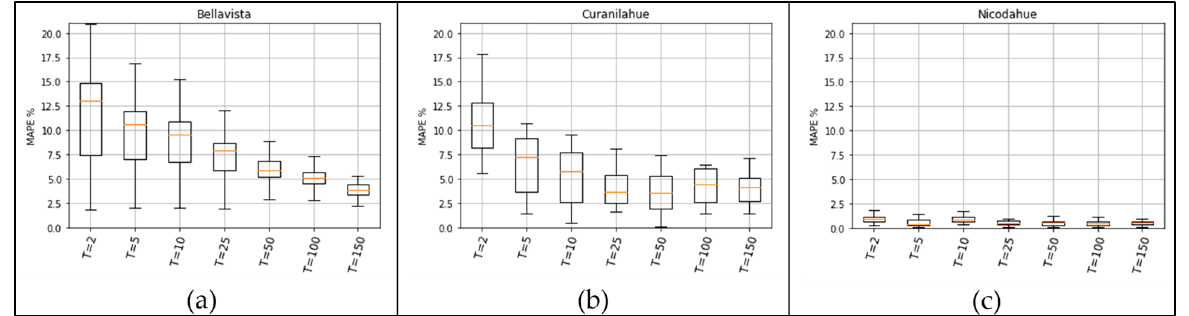
Figure 4. WSE-RS vs. WSE-T results for each cross section of the ( a ) Bellavista, ( c ) Curanilahue, and ( e ) Nicodahue rivers for different return periods. The dashed blue line shows the 1:1 ratio of WSE- T to WSR-RS and the red line shows the trend of the results and correlation (R). ( b , d , f ) show the distribution of differences between WSE-T and WSE-RS for the Bellavista, Curanilahue, and Nico- dahue rivers, respectively.